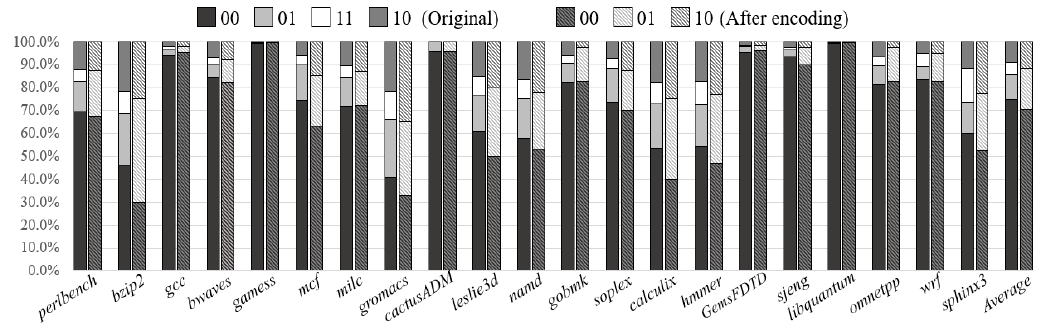
Figure 9. Frequencies of data patterns (00, 01, 11, 10) before / after encoding for the selected SPEC CPU 2006 benchmarks.